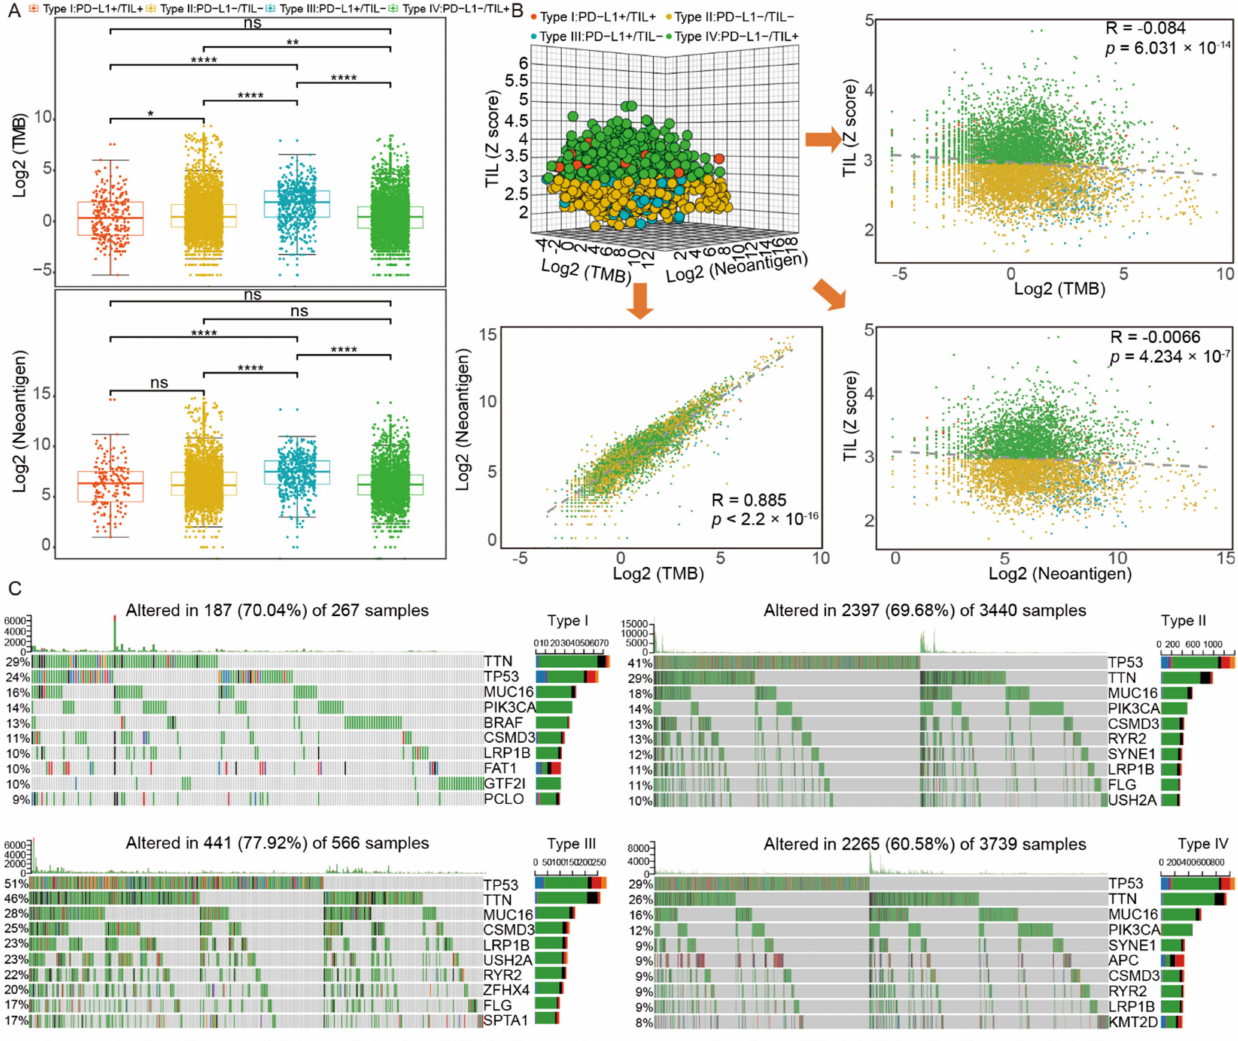
Figure 3. The genomics pattern discrepancy in four TIME subtypes. ( A ) The distribution of TMB and neoantigen among four subtypes; ( B ) correlation analysis among TIL, TMB, and neoantigen; ( C ) the alteration landscape of somatic variants across four subtypes. ****, p < 0.0001; ***, p < 0.001; **, p < 0.01; *, p <